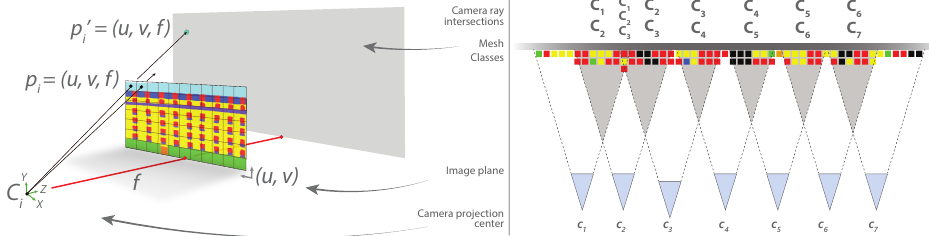
Figure 3. Ray-tracing analysis: This diagram shows the intersections of rays between the overlapped images, where the class assignment is made by choosing the most frequent class (mode) at the intersections. The colors on the right side of the picture, correspond to the pixels from different images, overlapping the same region on the mesh. To decide which class to assign, a simple mode (most frequent class) operation is